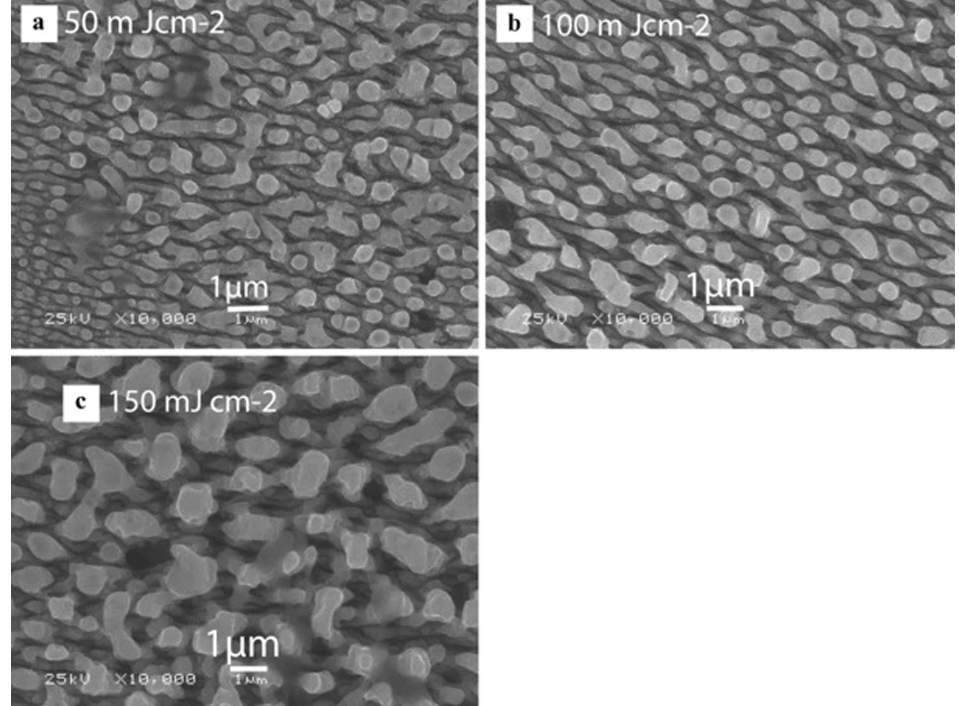
Figure 10. Dumbbell-shaped structure in ethanol environment. ( a ) 50 mJ cm − 2 ; ( b ) 100 mJ cm − 2 ; ( c ) 150 mJ cm − 2 . “Reprinted with permission from Ref. [38], Copyright (2013), Springer Nature”.